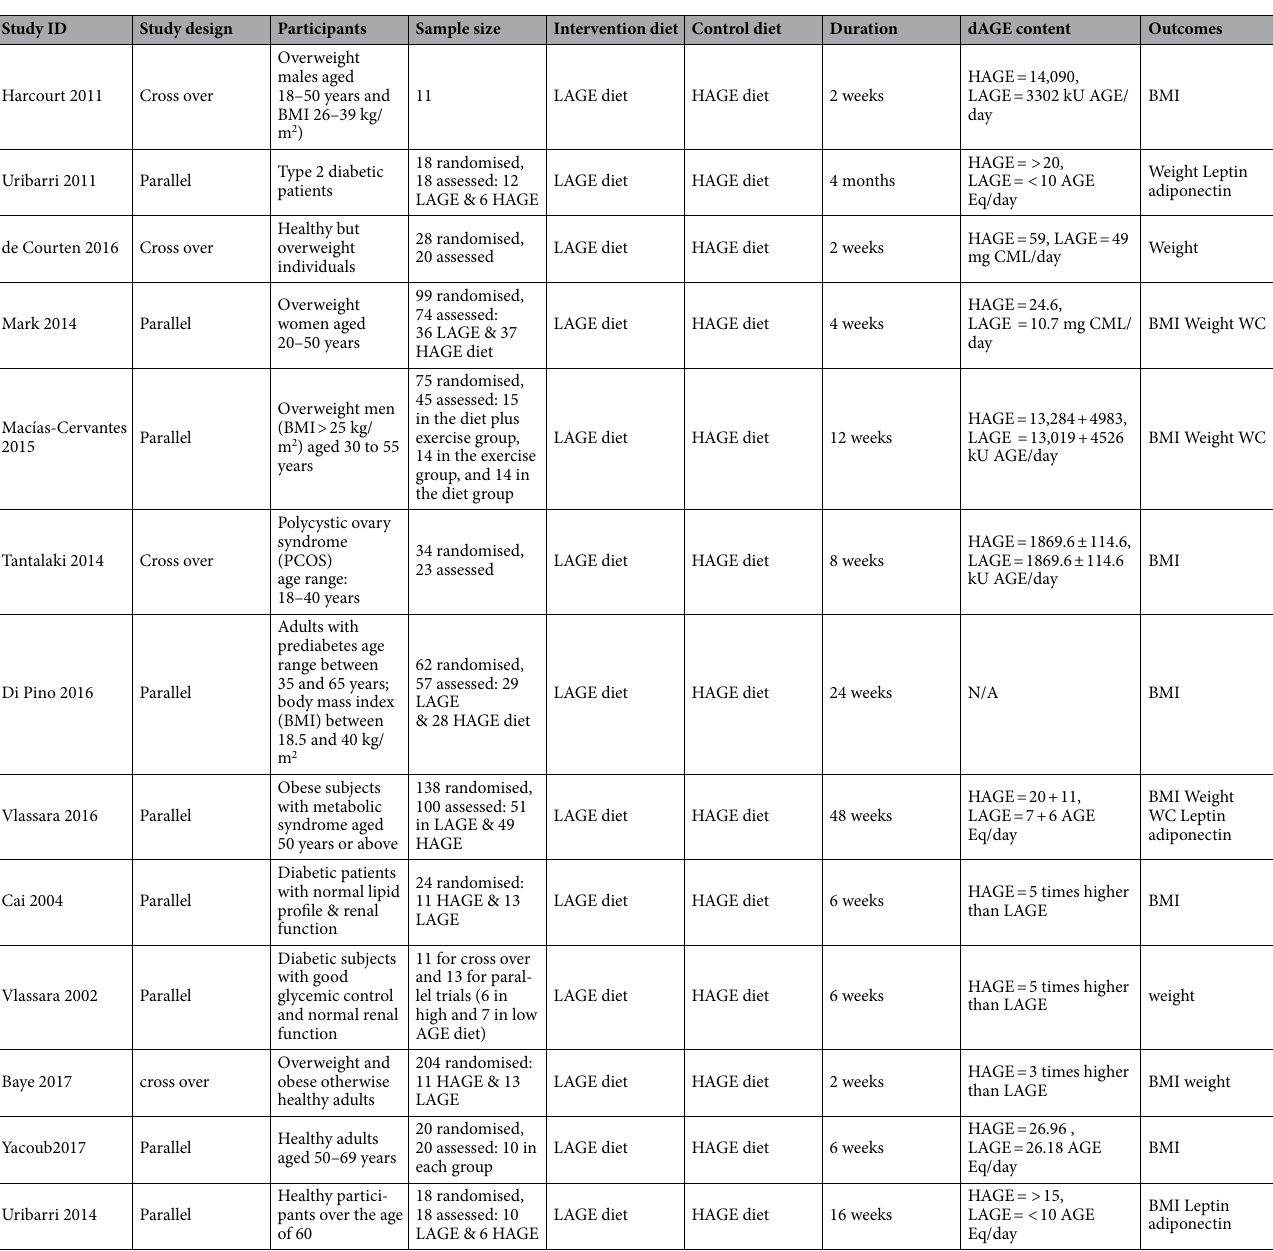
Table 1. Included randomized controlled trial study characteristics by population. WC; Waist circumference; BMI; Body mass